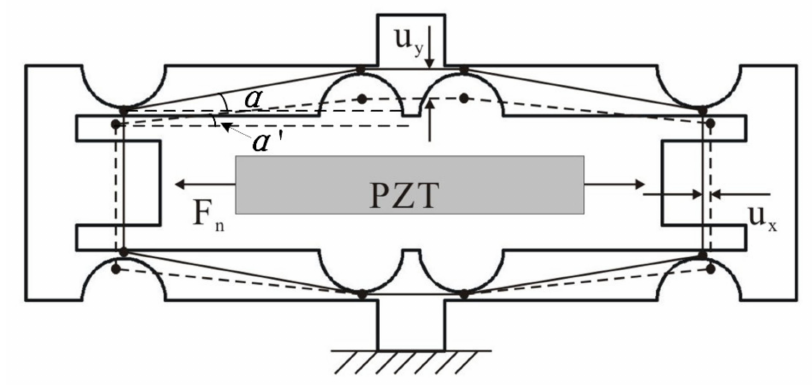
Figure 2. Piezoelectric micro-displacement actuator.